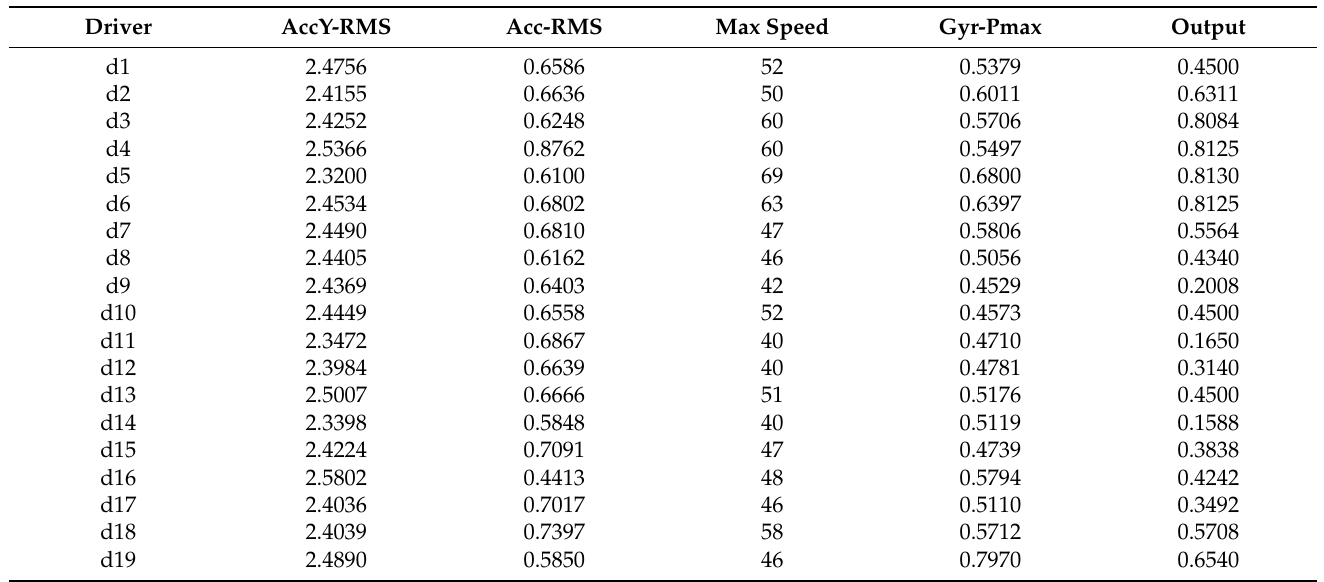
Table 2. Selected features from sensors.